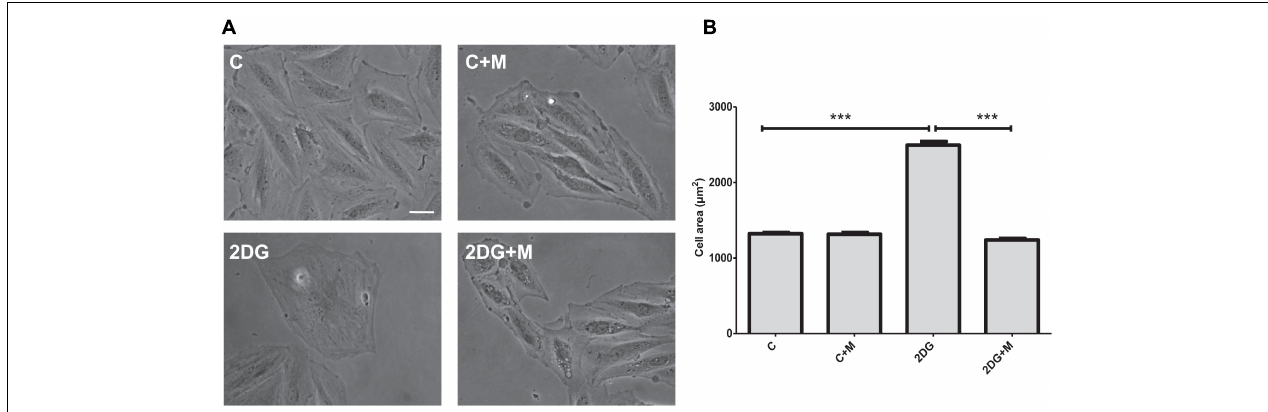
FIGURE 1 | Metformin attenuates cell hypertrophy in response to metabolic stress. (A) Representative images of H9C2 cells exposed to vehicle (C) or 2 mM 2-deoxyglucose (2DG) for 24 h in the presence or absence of 5 mM metformin (M). (B) Quantification of cell area from (A) . Data represents the mean ± SEM from at least three independent experiments. Scale bar is 100 µ m. Statistical analysis was carried out by one-way ANOVA: ∗∗∗ P < 0.001 between indicated conditions.